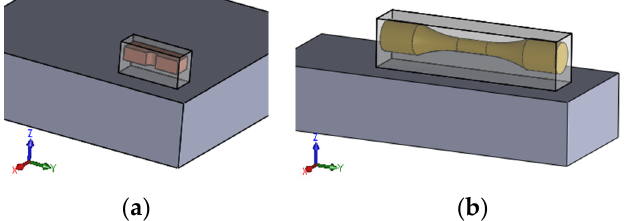
Figure 3. Build orientation: ( a ) Miniature bending; ( b ) Standard axial (z corresponds to the build orientation).